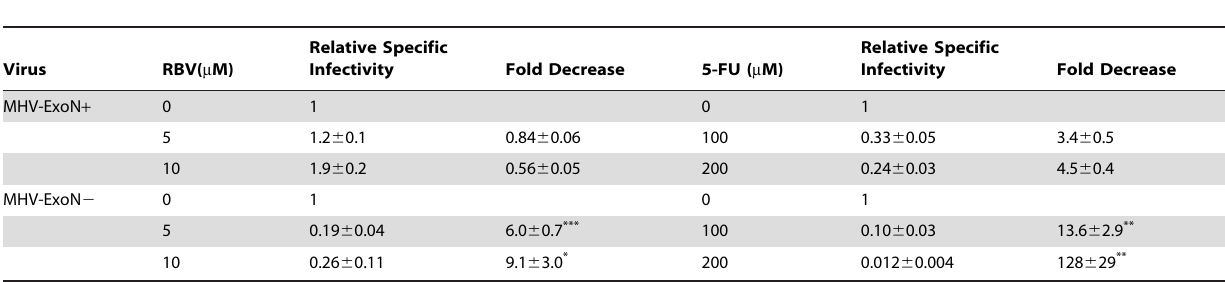
Table 1. Relative specific infectivities of MHV-ExoN + and ExoN 2 viruses following treatment with RBV or 5-FU.